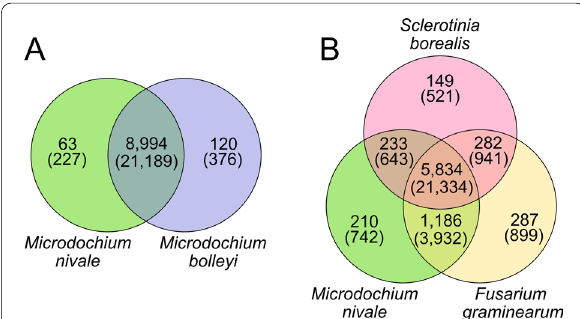
Fig. 5 Groups of orthologous proteins (orthogroups) unique to Microdochium nivale or shared between A M. nivale and M. bolleyi or B M. nivale , Sclerotinia borealis , and Fusarium graminearum . The numbers of the shared orthogroups are given within the corresponding areas, and the numbers of proteins within them are given in